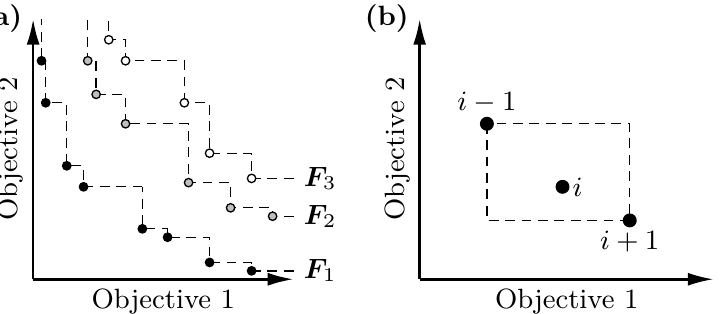
Figure 1. ( a ) Non-dominated sorting. Each solutions is assigned to a front F 1 to F n due to their non-domination level. ( b ) Crowd distance calculation. The crowding measure is shown for the i -th member of a front